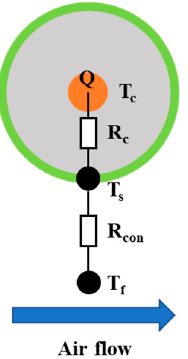
Figure 10. Mathematical model of a cell’s transversal section.